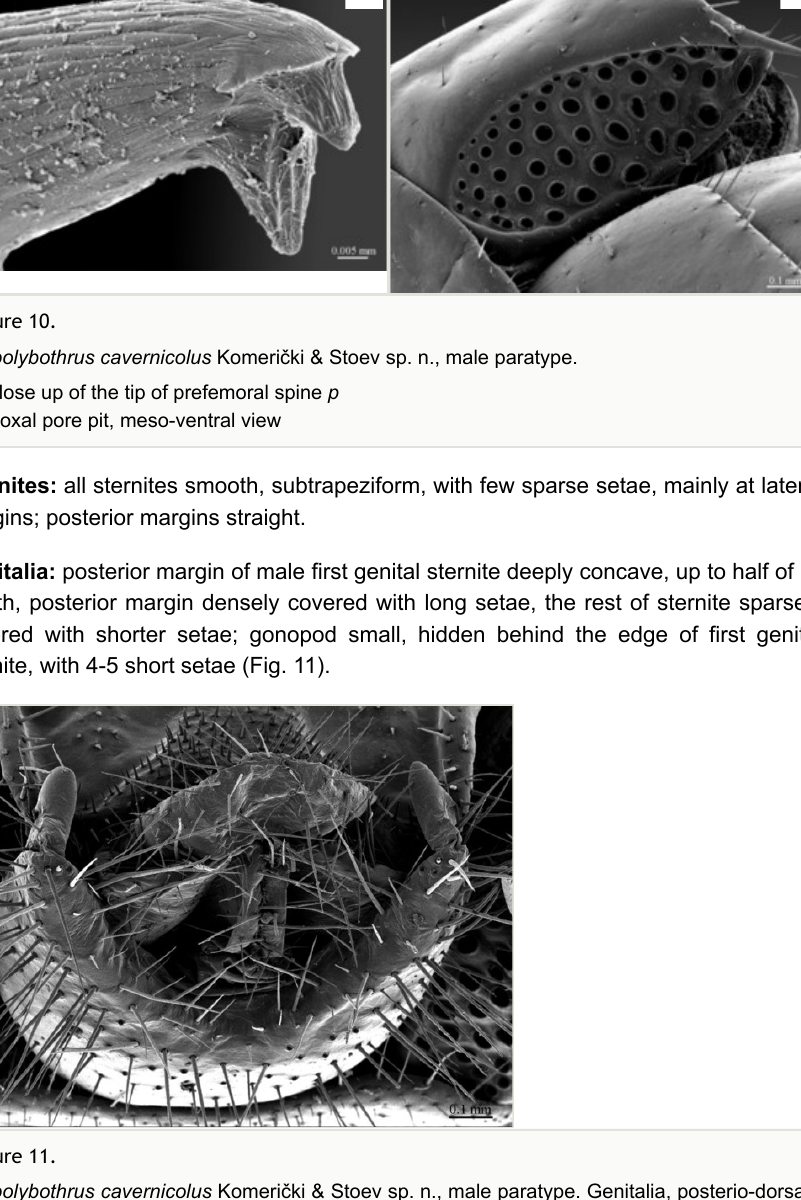
Plectrotaxy: as in Table 1.